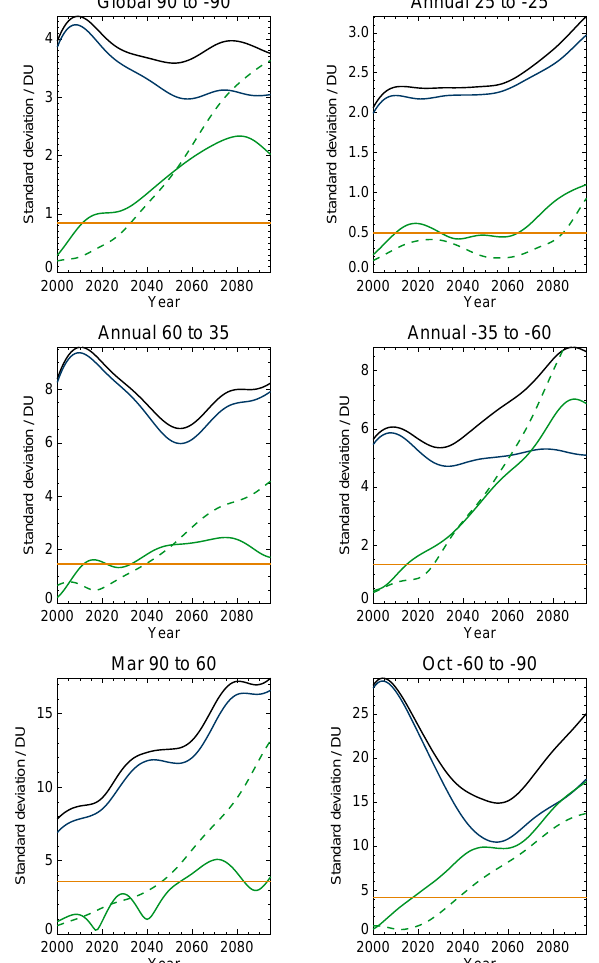
Fig. 3. Uncertainty in the predicted total-column ozone amounts, relative to 1980 values, estimated for different geographic regions (global, annual mean - top left, tropical annual mean - top right, NH mid-latitudes, annual - middle let, SH mid-latitudes, annual - middle right, NH polar cap, March - bottom left, SH polar cap bottom right). Uncertainty is expressed as the one standard deviation estimate for interannual variability (orange), model uncertainty (blue) and scenario uncertainty (green) and the total (black). Solid green lines show calculations of scenario uncertainty using four model integrations run with SRES scenarios. Dashed green lines show calculations of scenario uncertainty using three integrations of CAM3.5 run with RCP scenarios.